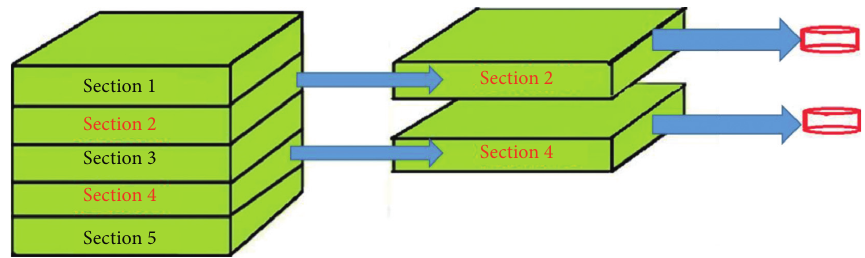
Figure 4: Sections of the concrete